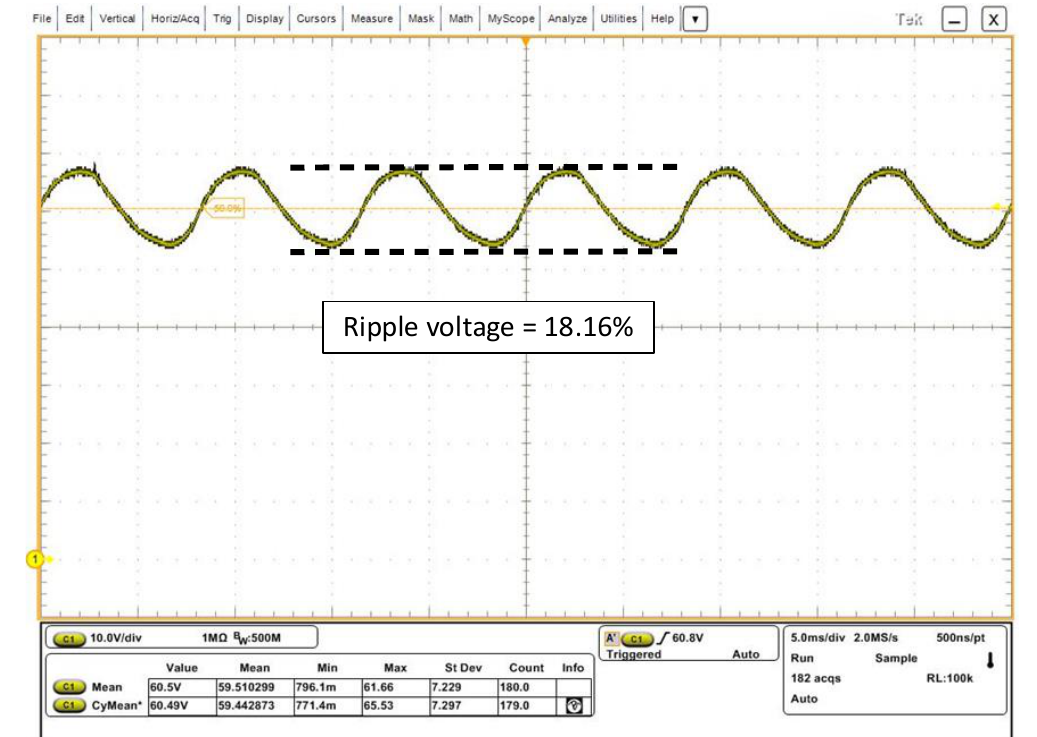
Figure 17. PF obtained in experimental tests of the power quality meter.